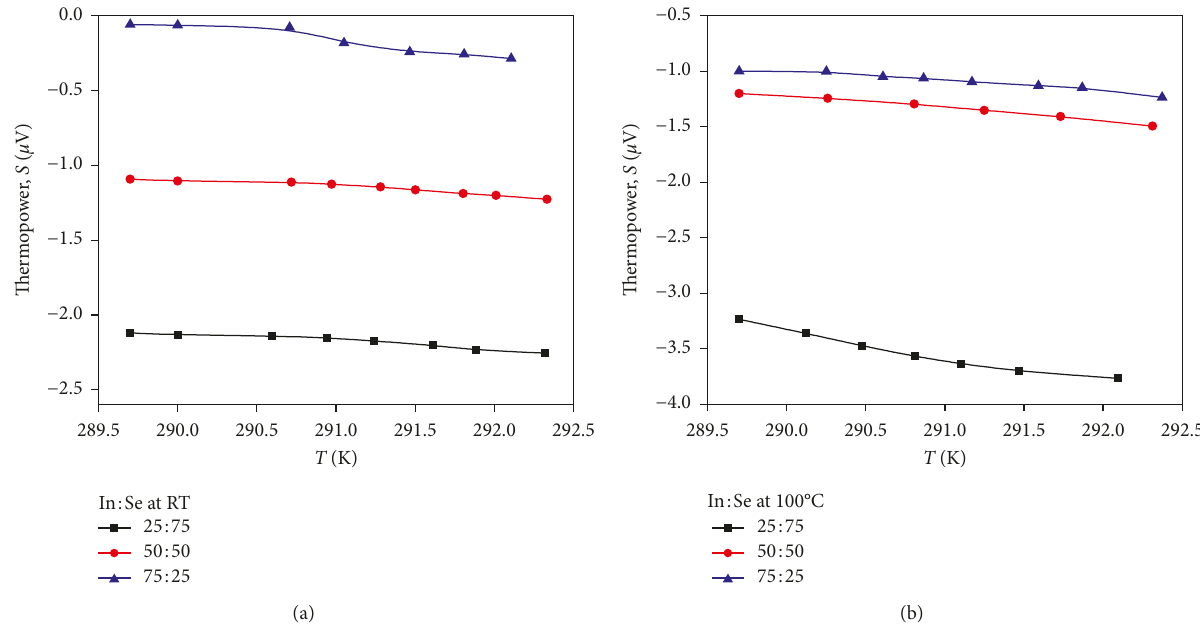
Figure 11: Graph between thermoelectric power and temperature for InSe: (a) RT and (b) 100 ° C.